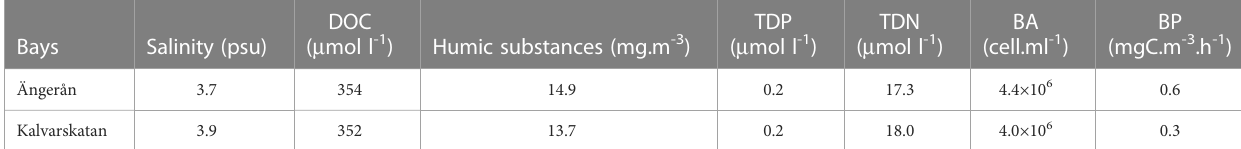
TABLE 1 Chemical and biological characteristics of the seawater in the two bays.